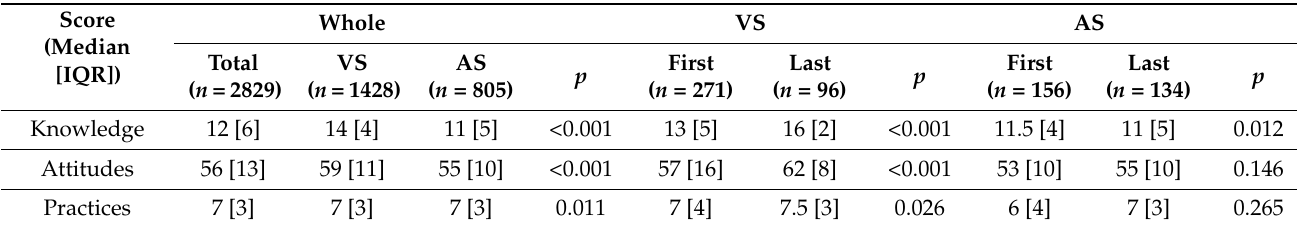
Table A1. Knowledge (K), Attitudes (A) and Practices (P) scores in veterinary and agriculture undergraduate